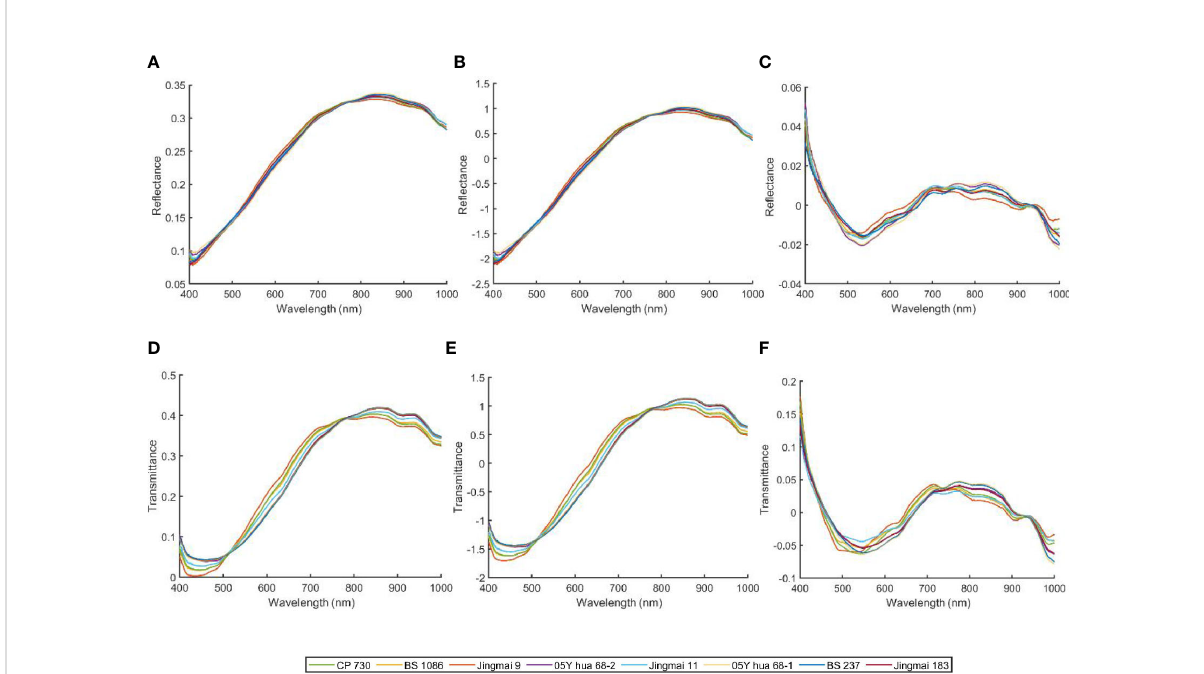
FIGURE 5 Spectral curves of different preprocessing methods: re fl ectance spectral curves after (A) MSC processing, (B) SNV processing, and (C) Detrend processing; transmittance spectral curves after (D) MSC processing, (E) SNV processing, and (F) Detrend processing. MSC, multiplicative scatter correction; SNV, standard normal variable